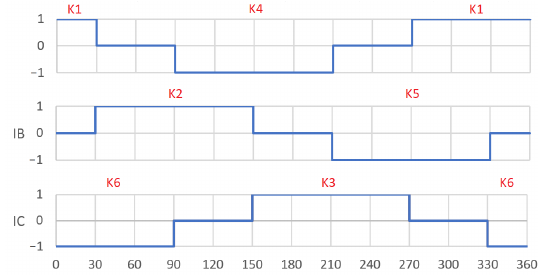
Figure 4. Adopted power supply system for successive coils.